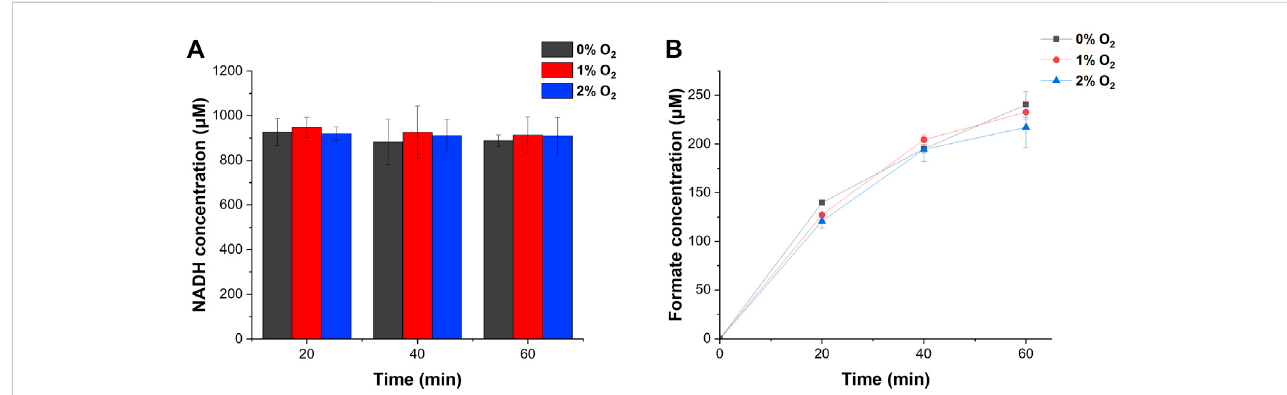
FIGURE 4 H 2 and CO 2 conversion into formate by NAD + -dependent ReSH and RcFDH cascade reactions. (A) NADH concentration. (B) Formate concentration. All measurements were performed in